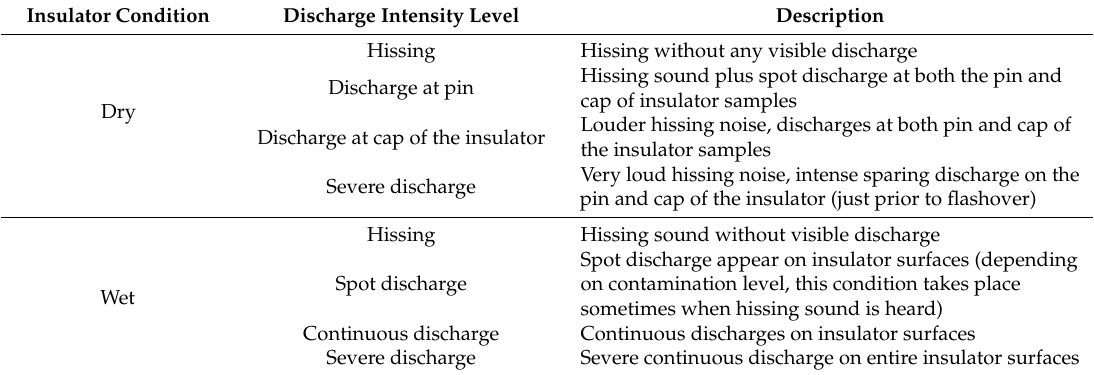
Table 4. Classification of insulator surface discharge intensity levels.